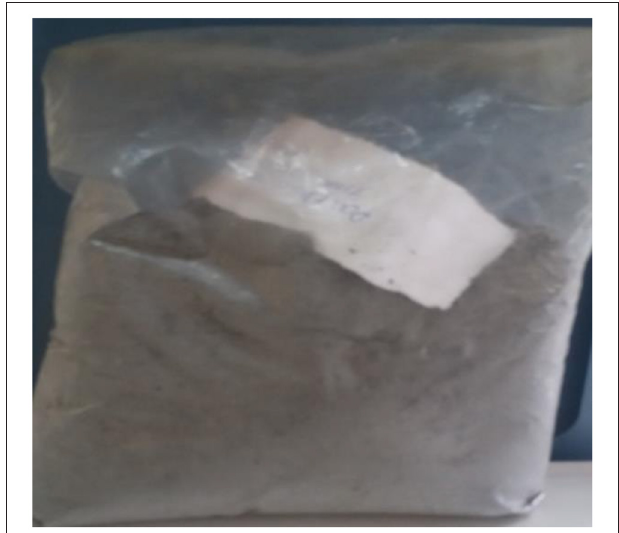
FIGURE 3 | The ash prepared from Parthenium weed (By Tesfaye G, May